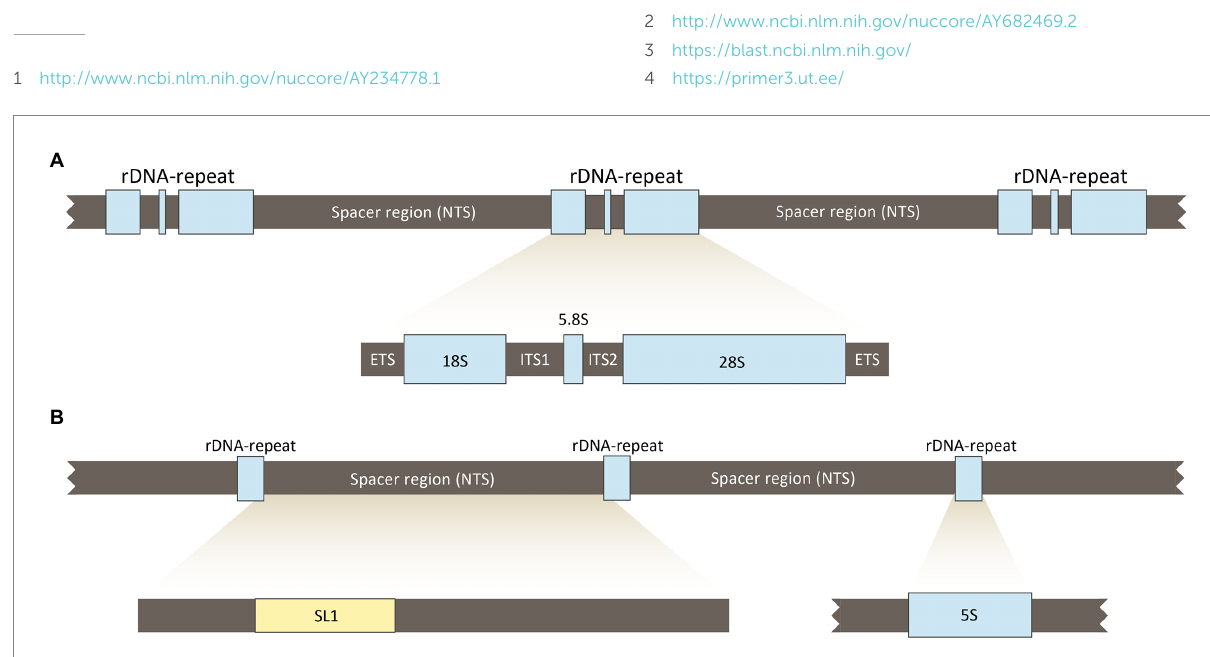
FIGURE 2 The major and minor multigene families of the ribosomal DNA (rDNA) of Enterobius vermicularis . In (A) is reported the major family; it is arranged in tandemly repeated clusters (r-DNA-repeat), separated by non-transcribed spacer regions (NTS). In (B) is reported the minor gene family; it is also organized in tandem repeated clusters (r-DNA-repeat), separated by non-transcribed spacer regions (NTS). ETS, external transcribed spacers region; ITS, internal transcribed spacers